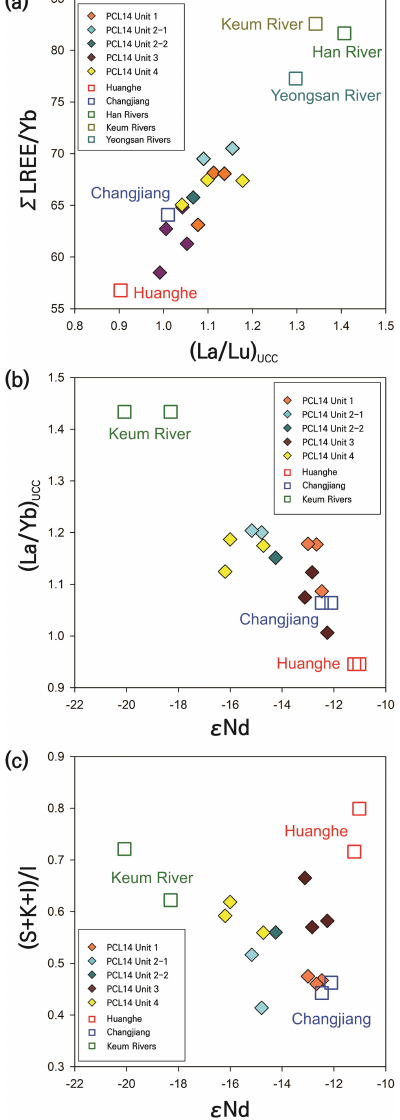
Figure 6. Discrimination plots showing variations in (a) (cid:80) LREE / Yb vs. (La / Lu) UCC , (b) (La / Yb) UCC vs. ε Nd, and (c) (smectite + kaolinite + chlorite)/illite vs. ε Nd. Clay mineral (Cho et al., 2015; Koo et al., 2018), rare earth element (Xu et al., 2009), and isotope data of potential sources are also shown for